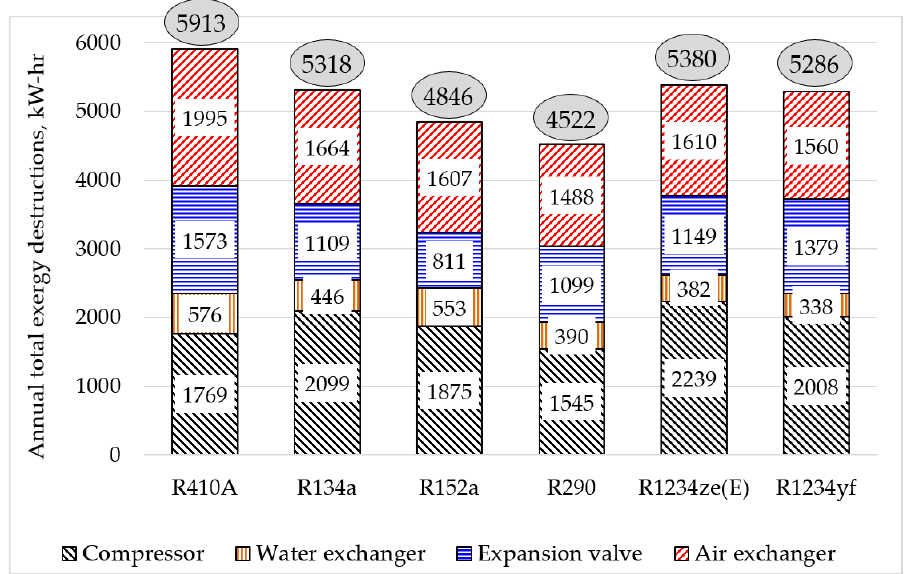
E D,k (kWh) in the components of the investigated